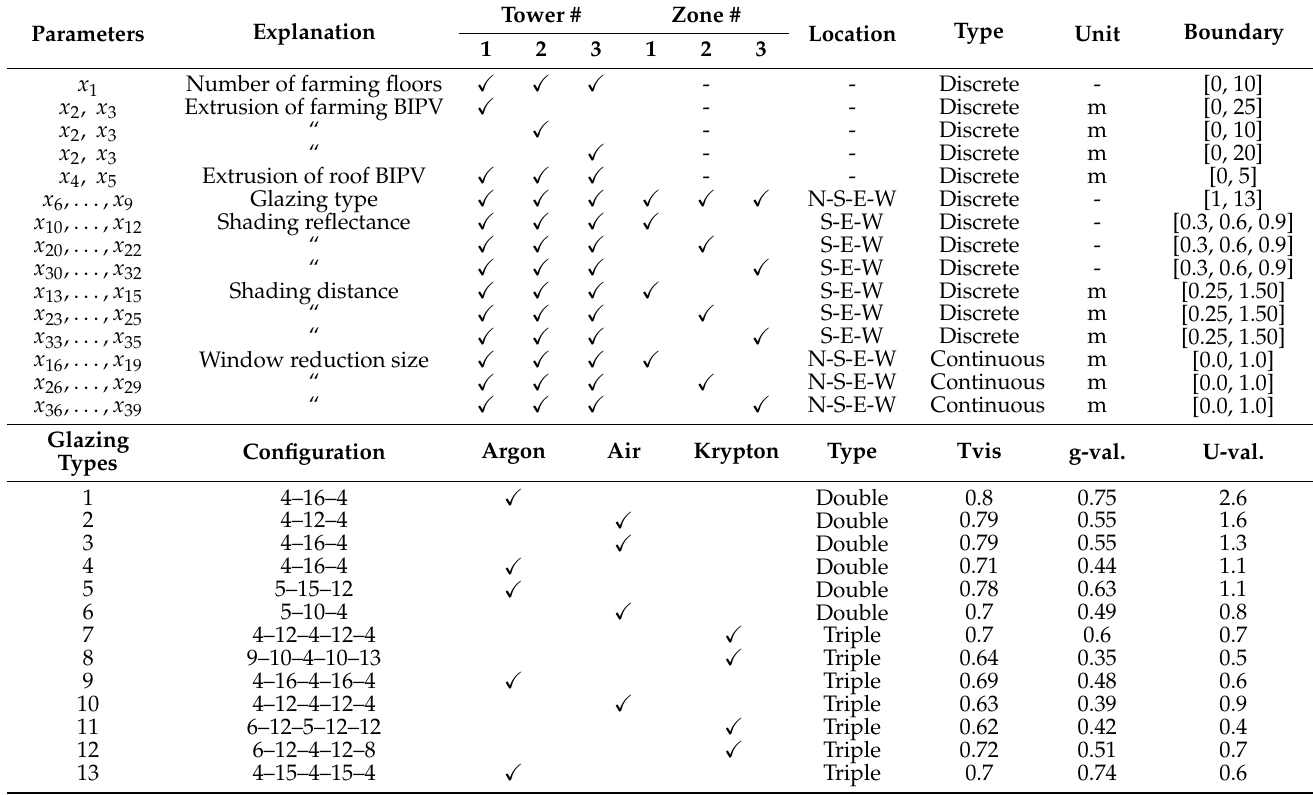
Table 3. Decision variables and glazing